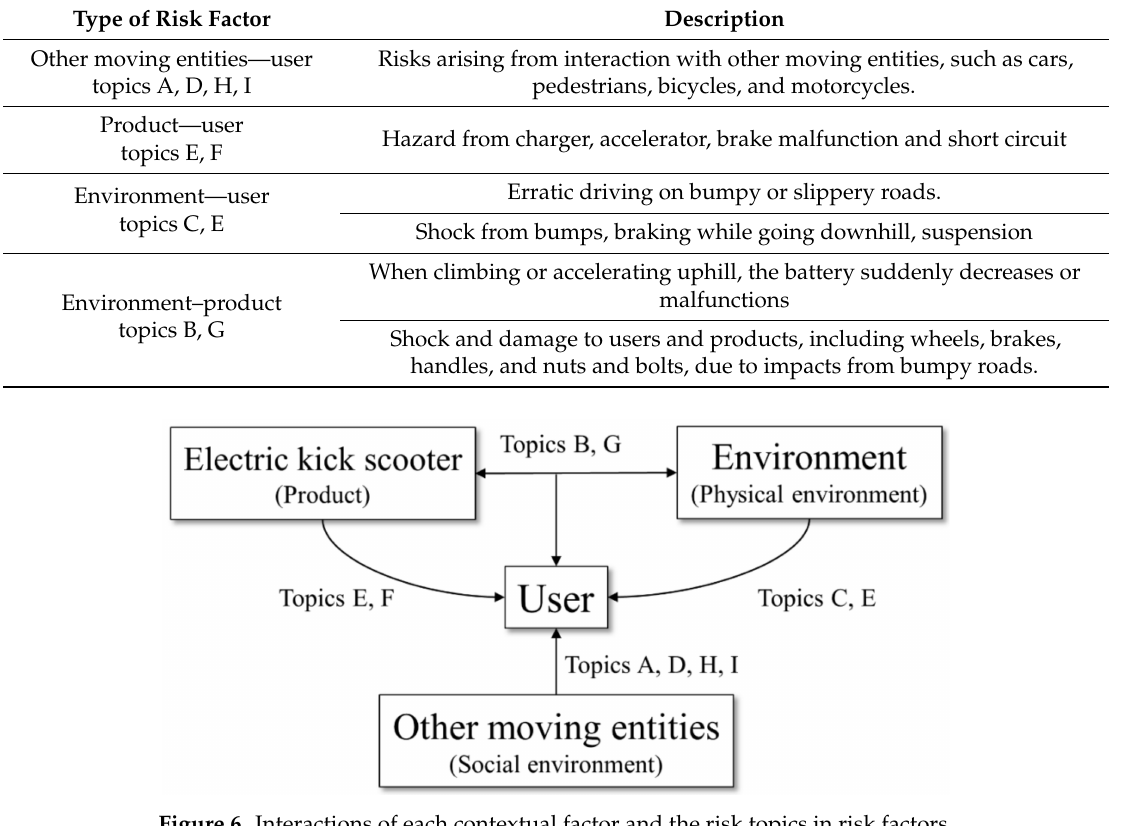
Figure 6. Interactions of each contextual factor and the risk topics in risk